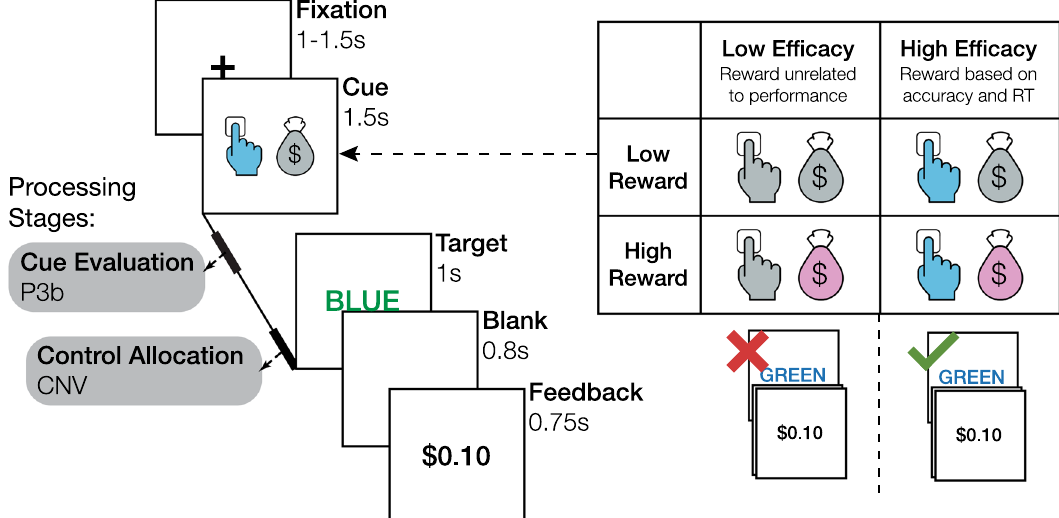
Fig. 2 Manipulation of expected reward and ef fi cacy. On each trial, participants view an incentive cue followed by a Stroop stimulus (target) and then feedback indicating how much reward they received. Four different cues indicate whether a trial is high or low in reward and ef fi cacy. The P3b and CNV event-related potentials are measured during the interval between cue and target, as indices of cue evaluation (P3b) and control allocation